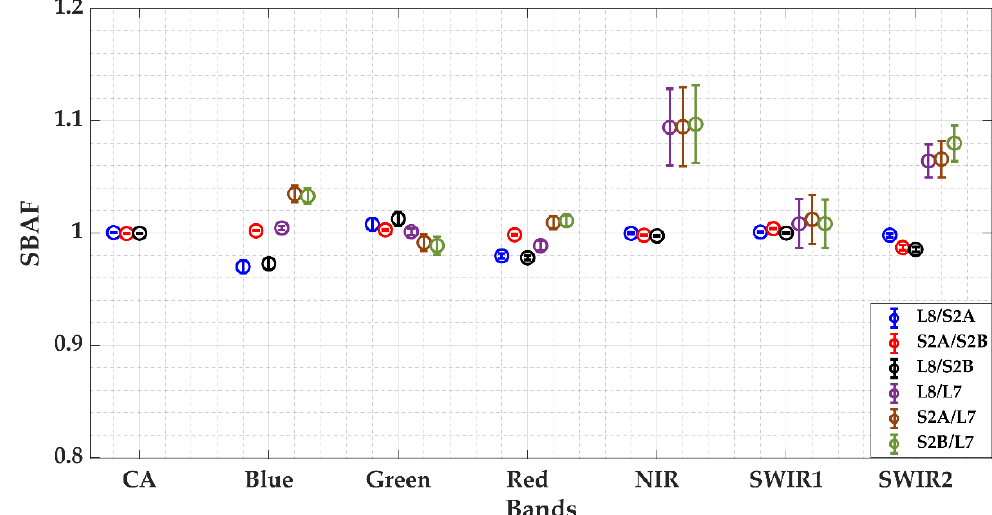
Figure 3. Spectral Band Adjustment Factors derived from the hyperspectral profile of Cluster 13 for each sensor pair (error bars represents the standard deviation at k = 2. The sensor in the numerator is the reference sensor for each combination).